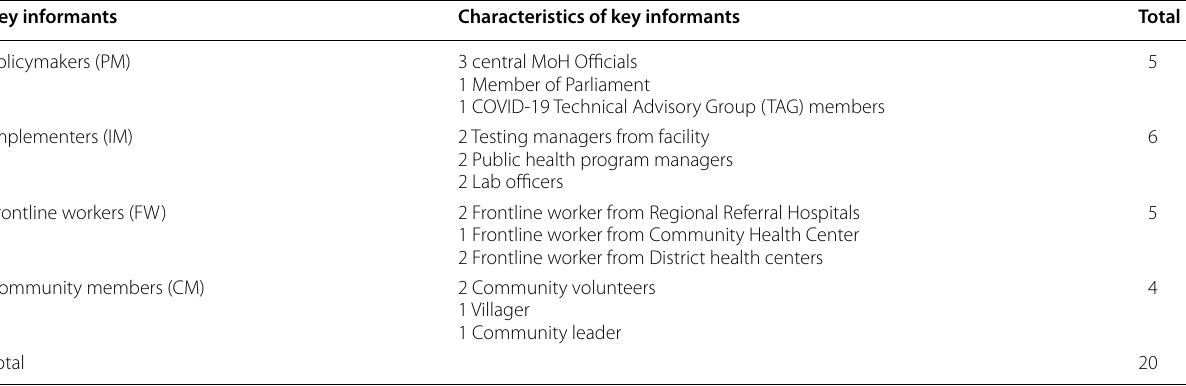
Table 1 Characteristics of key informants interviewed Key informants Characteristics of key